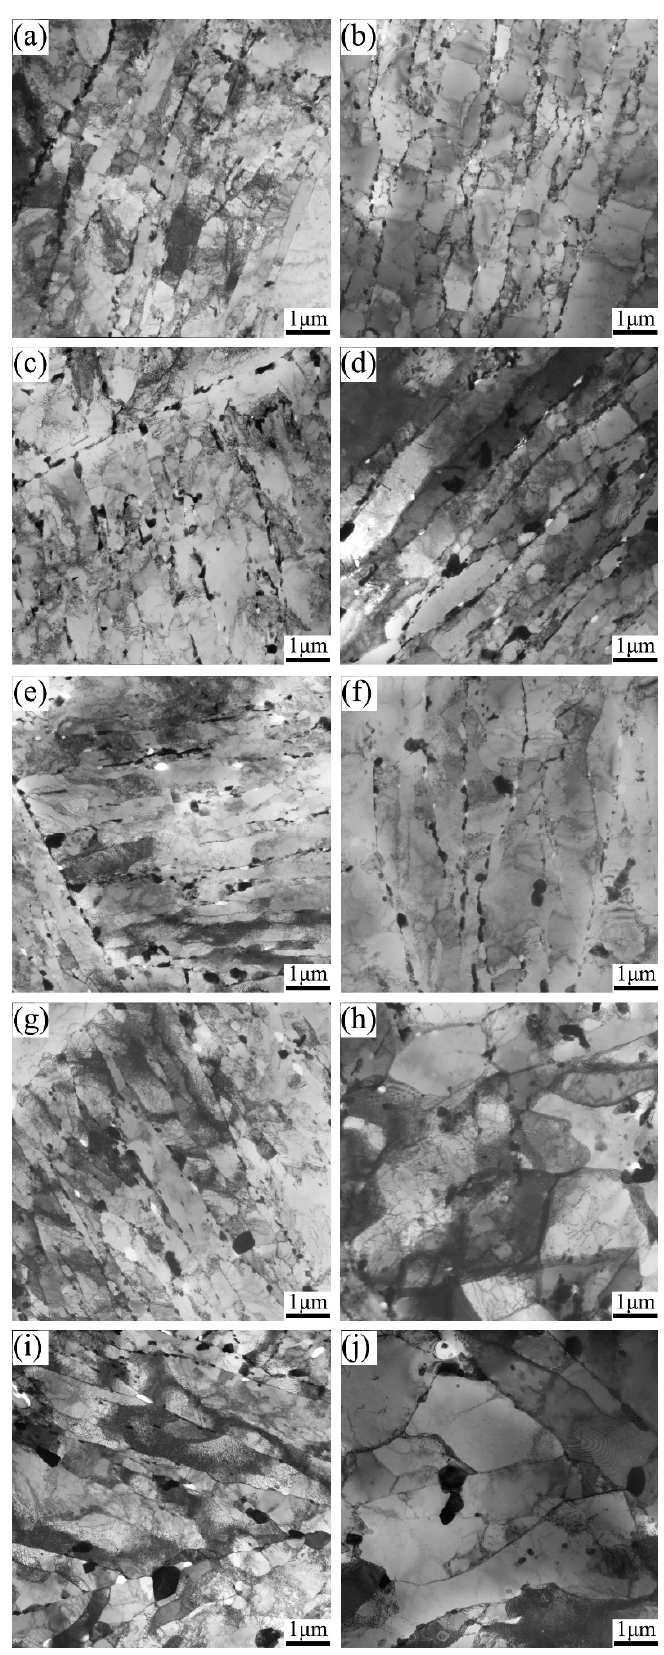
Figure 7. TEM images of 9Cr-3W-3Co steel after creep tests at 650 °C: specimens ruptured after ( a , b ) 134 h, ( c , d ) 837 h, ( e , f ) 3037 h, ( g , h ) 6667 h, ( i , j ) 17,991 h. ( a , c , e , g , i ) are from grip areas; ( b , d , f , h , j ) are from gauge areas.